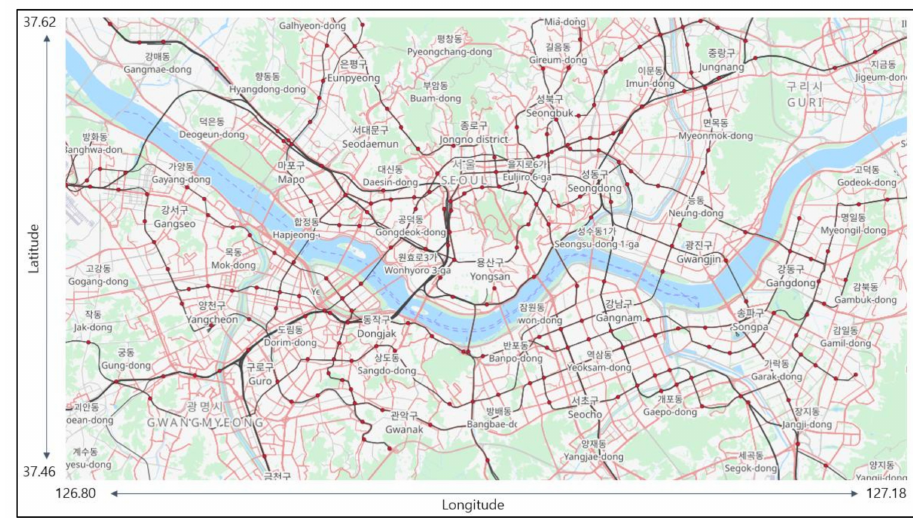
Figure 1. Latitude and longitude bound for the distance and time sampling.